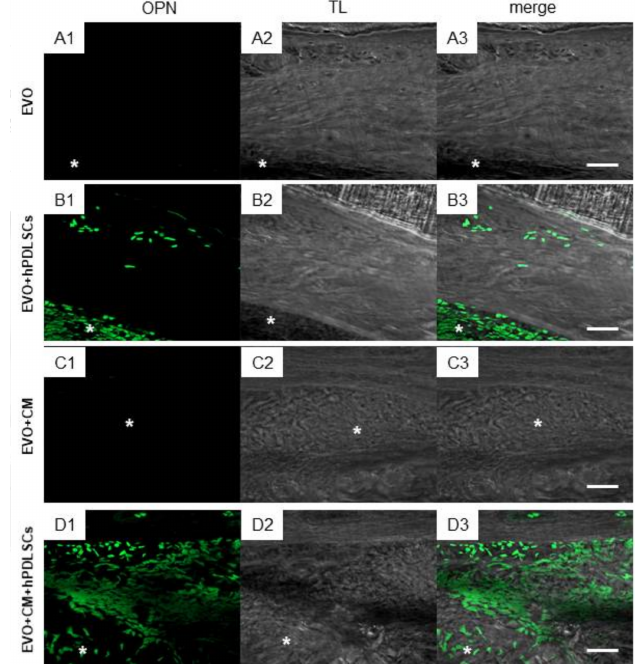
Figure 5. In vivo osteopontin (OPN) expression. Immunofluorescence staining of OPN showed the presence of the protein in calcified semithin section samples grafting in rat calvaria in ( A1 – A3 ) EVO; ( B1 – B3 ) EVO + hPDLSCs; ( C1 – C3 ) EVO + CM; ( D1 – D3 ) EVO + CM + hPDLSCs. The captured images showed a higher protein expression in EVO + CM + hPDLSCs. (OPN: green; TL, transmission light: gray). Mag: 40 × . *: EVO. Bars: 50 µ